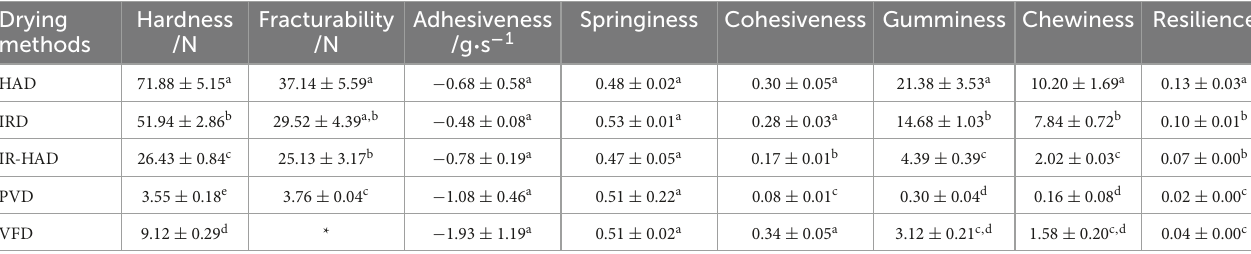
TABLE 2 Effects of different drying methods on the texture of sea buckthorn. Drying